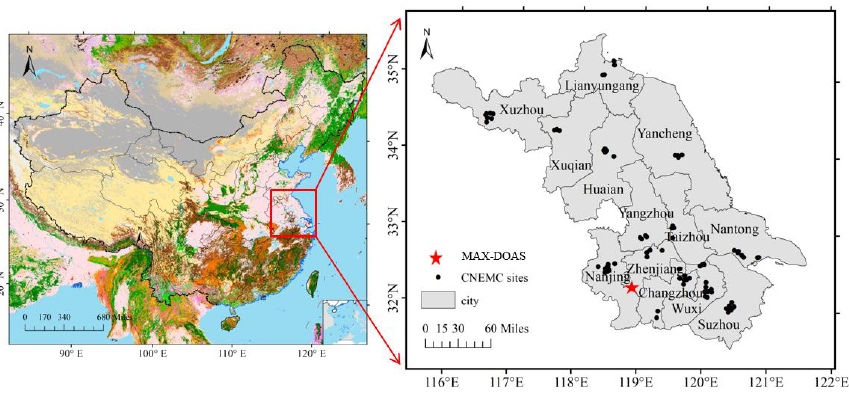
Figure 1. Distribution of the 87 CNEMC sites and MAX-DOAS in Jiangsu Province .